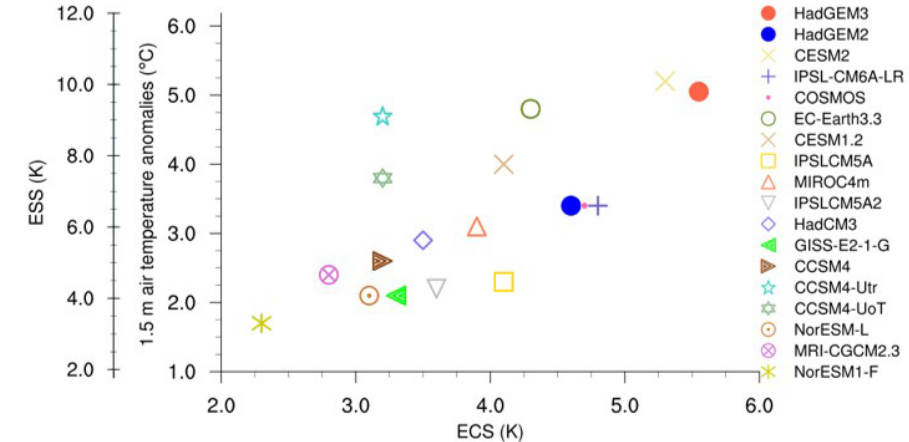
Figure 16. Global annual mean SAT anomalies versus both ESS (first y axis) and ECS from HadGEM3 mPWP simulation, HadGEM2 and all other models in PlioMIP2. The ESS axis is calculated by multiplying the global annual mean SAT anomaly by log(560 / 280) / log(400 / 280), i.e. by 1.94, meaning the axis here goes from 1.94 to 11.64K; for simplicity, this has been rounded up to